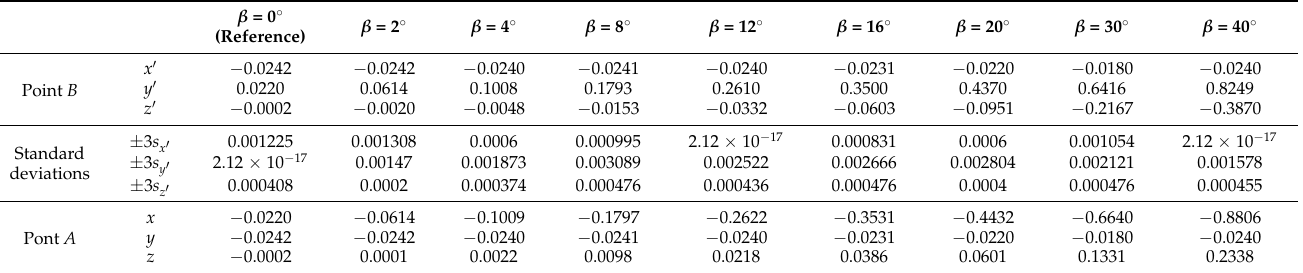
Table 2. Coordinates of the obtained x (cid:48) y (cid:48) z (cid:48) and recalculated xyz coordinates of the respective points B and A , for Sample 1, Probe 1, α = 90 ◦